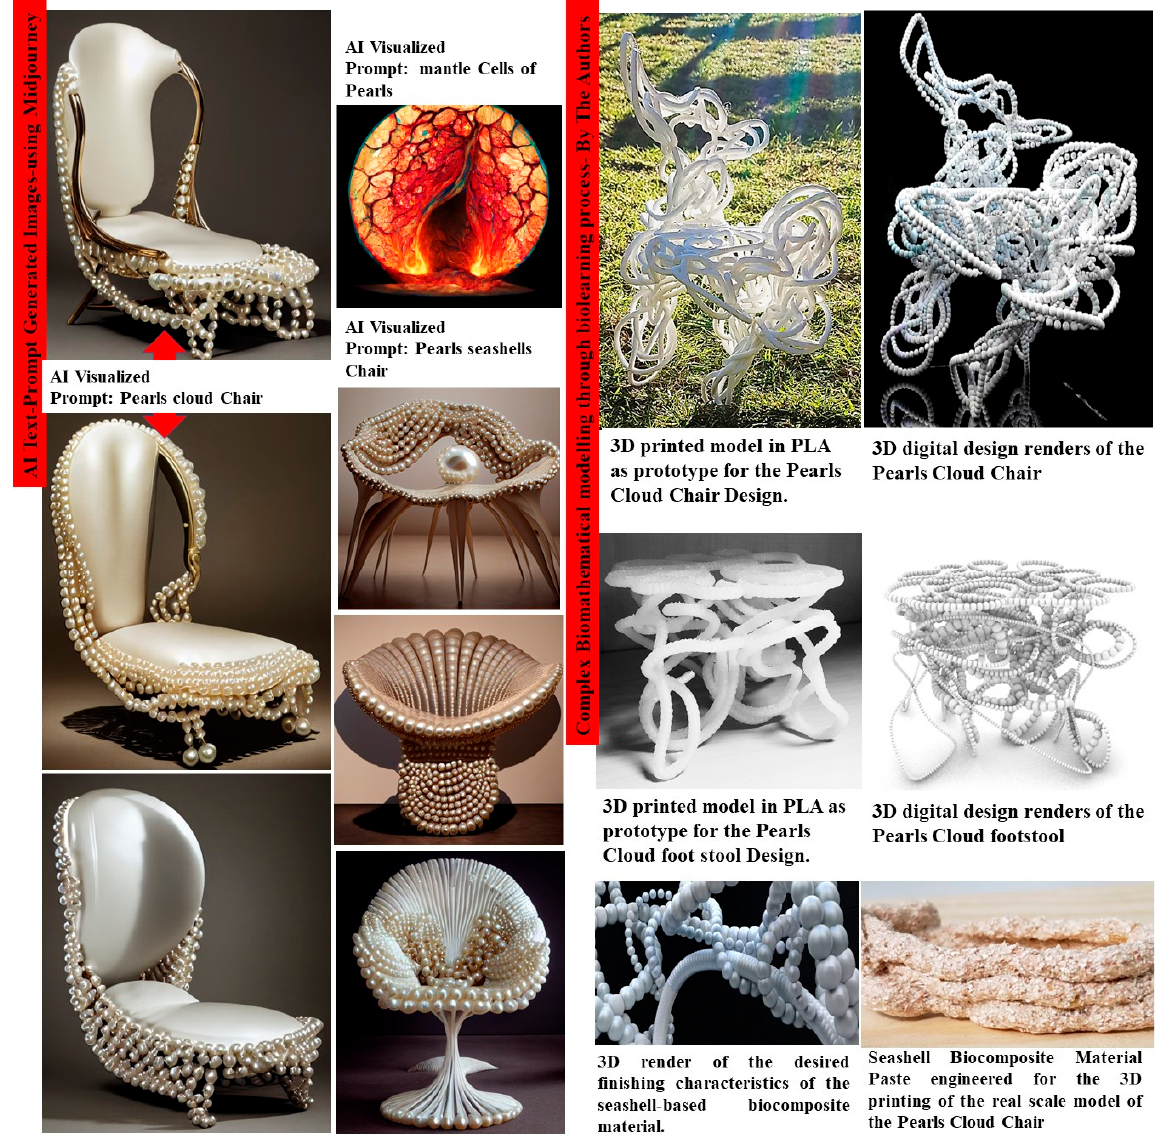
Figure 4. The pearl cloud chair seashell-based biocomposite material from food waste: comparison of the biomaterials research-driven design process between biolearning biomathematical modeling by the authors and the form-finding process using AI text-prompt-generated